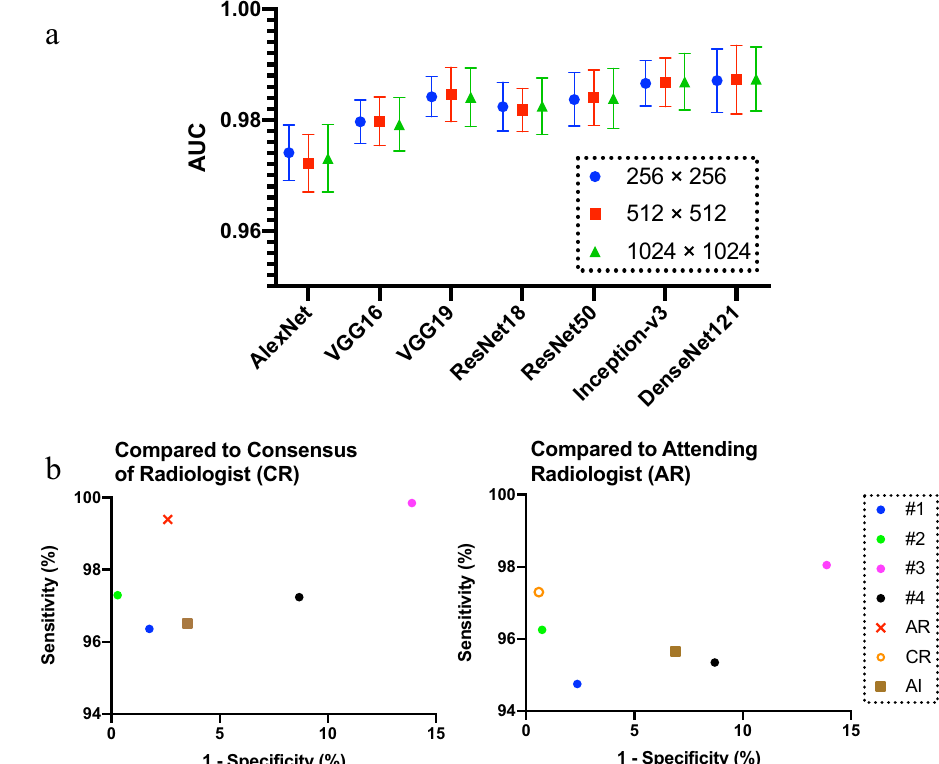
Fig. 2 Comparisons of model performance and different radiologists. a Performance of different CNN architectures with different input image sizes on the NIH “ ChestX-ray 14 ” dataset. CNN weights were initialized from the ImageNet pre-trained models. Performances are not signi fi cantly different among different input image sizes. The error bars represent the standard deviations to the mean values. b True positive rate (sensitivity) and false positive rate (1-speci fi city) of different radiologists (#1, #2, #3, and #4) against different ground-truth labels. Left depicts performance comparisons when setting the consensus of radiologists as ground-truth. Right depicts comparisons when setting labels from attending radiologist as ground-truth. AR attending radiologist, CR consensus of radiologists (vote by the majority of three board- certi fi ed radiologists), AI the arti fi cial intelligence model (ResNet18 CNN model shown